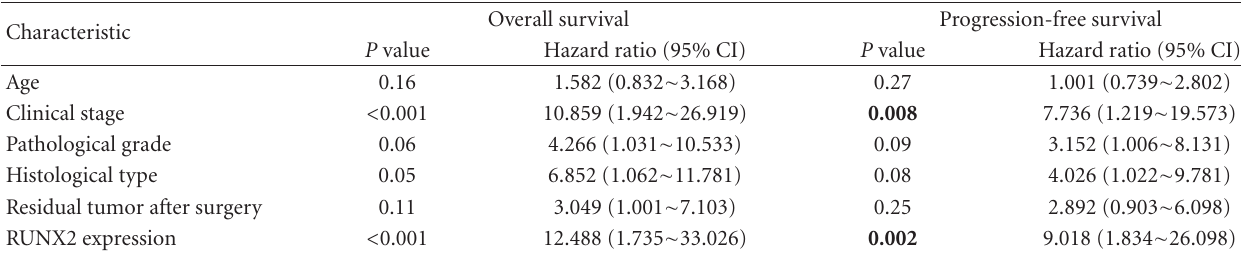
Table 2: Univariate analysis: factors predicting overall and progression-free